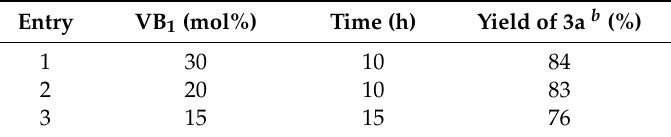
Table 2. The optimization of the amount of catalyst a.